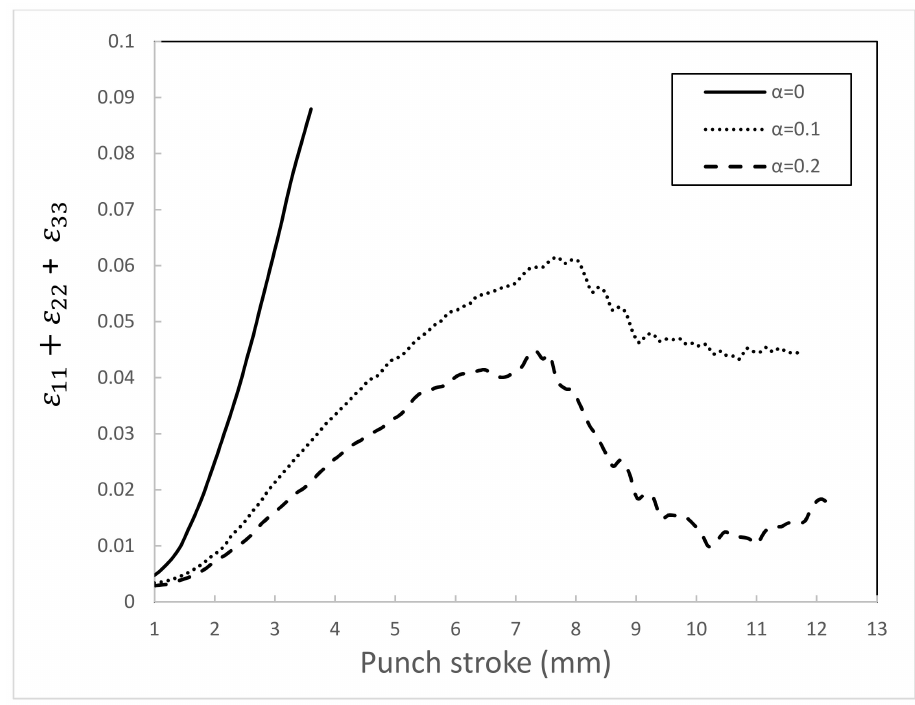
Figure 12. Volumetric strain in metal sheet with 10 mm width under various